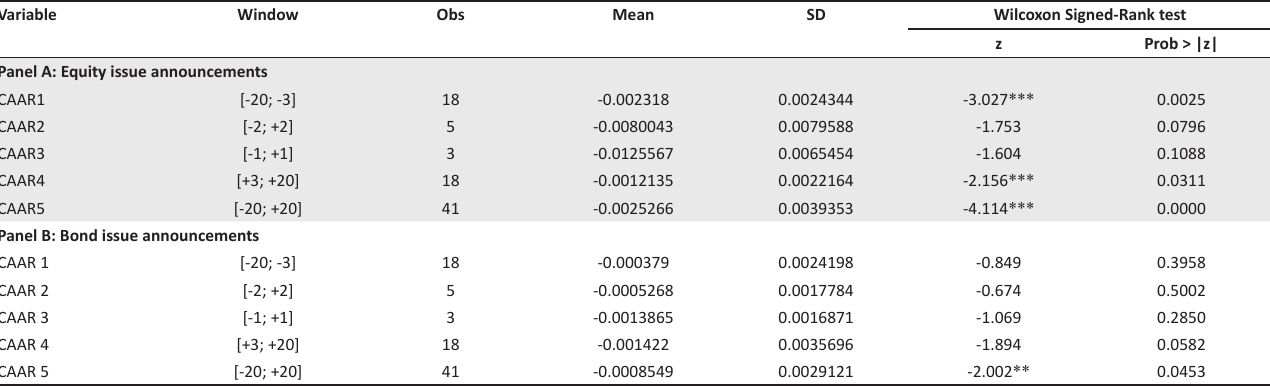
TABLE 1: The average values of cumulative average abnormal returns across different windows relative to the announcement of bond and equity issues. Variable